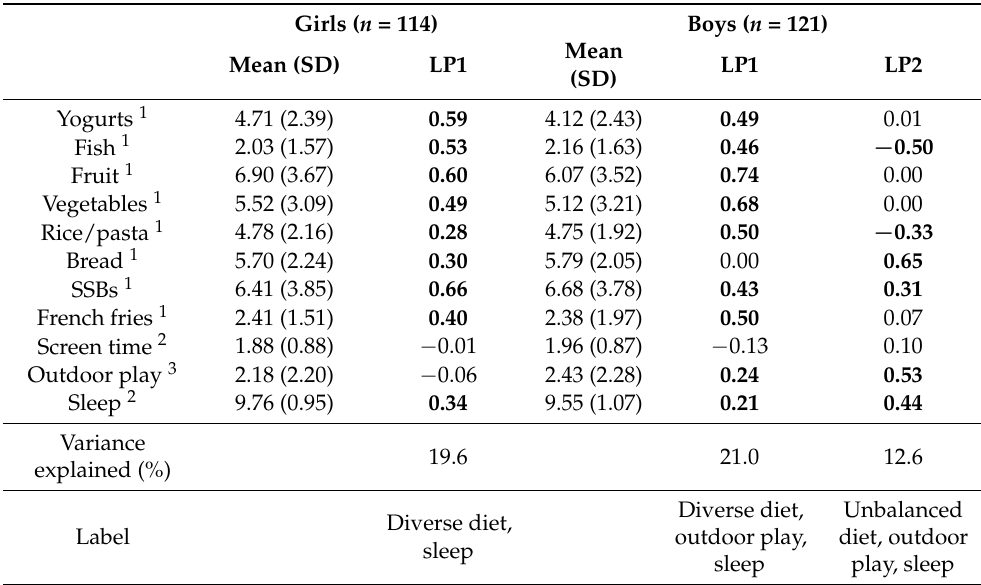
Table 2. Distribution of EBRBs and principal component factor loadings for lifestyle patterns in girls and boys aged 6–12 years. The ENFAMS